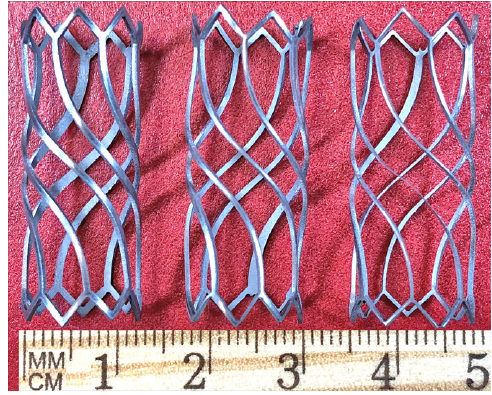
Figure 9: AWJ-machined stents with three different web widths.